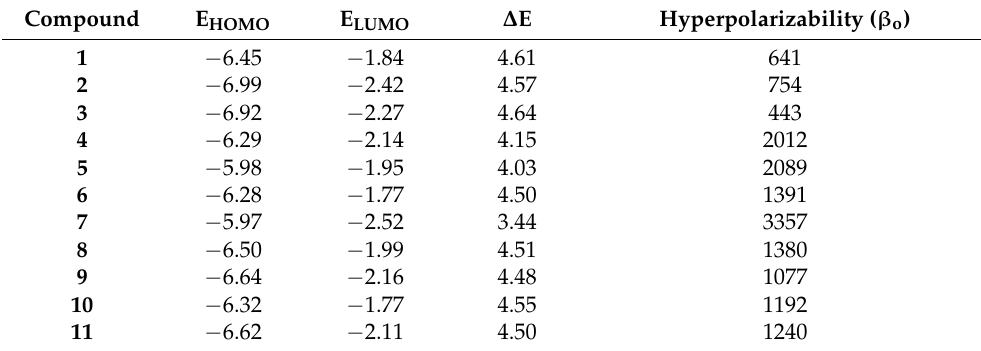
Table 4. Energies of HOMO–LUMO, energy gap, and hyperpolarizability values of 1 to 11 . The units of β o are Hartree while all the other energies are shown in eV.